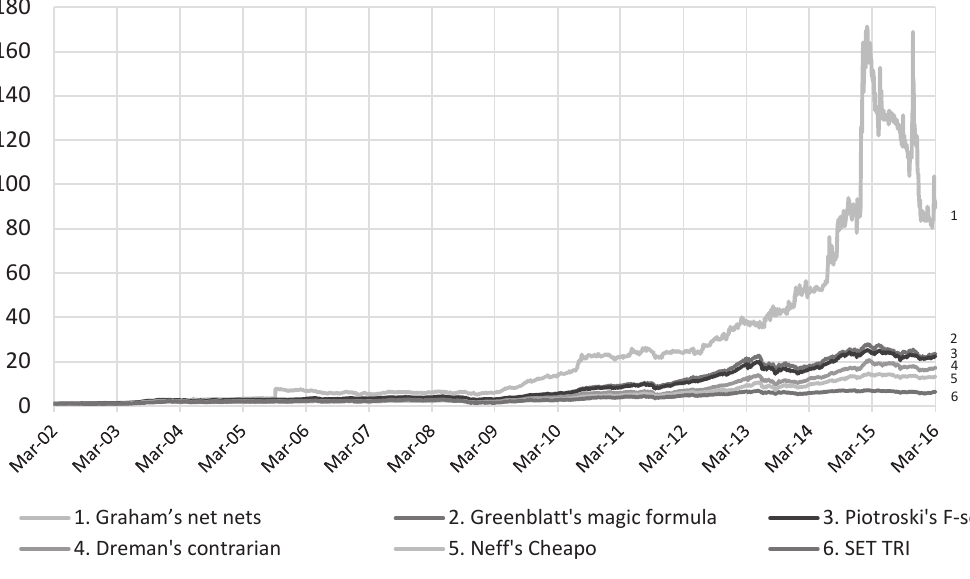
Figure A1. Accumulated value of each portfolio of the SET TRI over 14 years